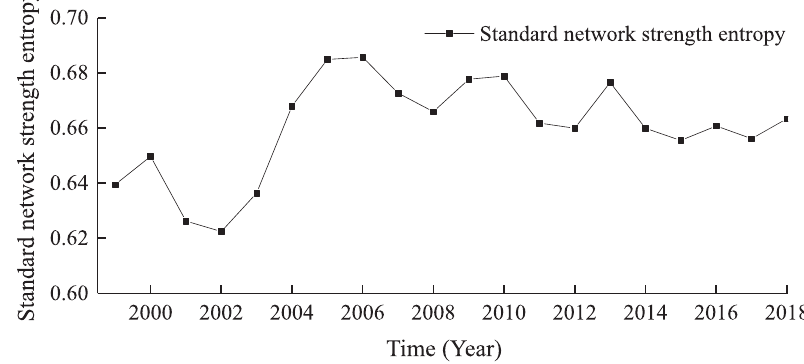
Figure 8. Standard network strength entropy changes from 1999 to